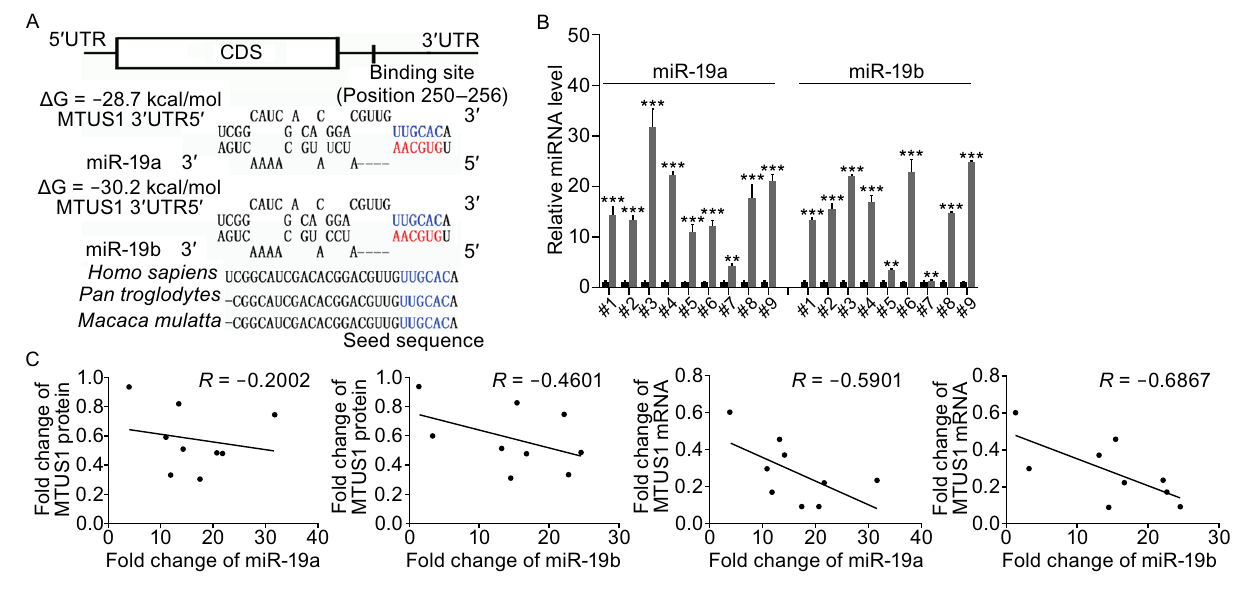
Figure 2. Inverse correlation between miR-19a/b and MTUS1 levels in lung cancer tissue samples. (A) Schematic description of the hypothetical duplexes formed by interactions between the MTUS1 3 ′ -UTR (top) and miR-19a/b (bottom). The predicted free energy value of each hybrid is indicated. The seed recognition sites are denoted, and all nucleotides in these regions are highly conserved across several species. (B) Quantitative RT-PCR analysis of miR-19a/b levels in 9 pairs of NCT and LCT samples. (C) Pearson ’ s correlation scatter plot of the fold changes in miR-19a/b and MTUS1 protein/mRNA expression in lung cancer